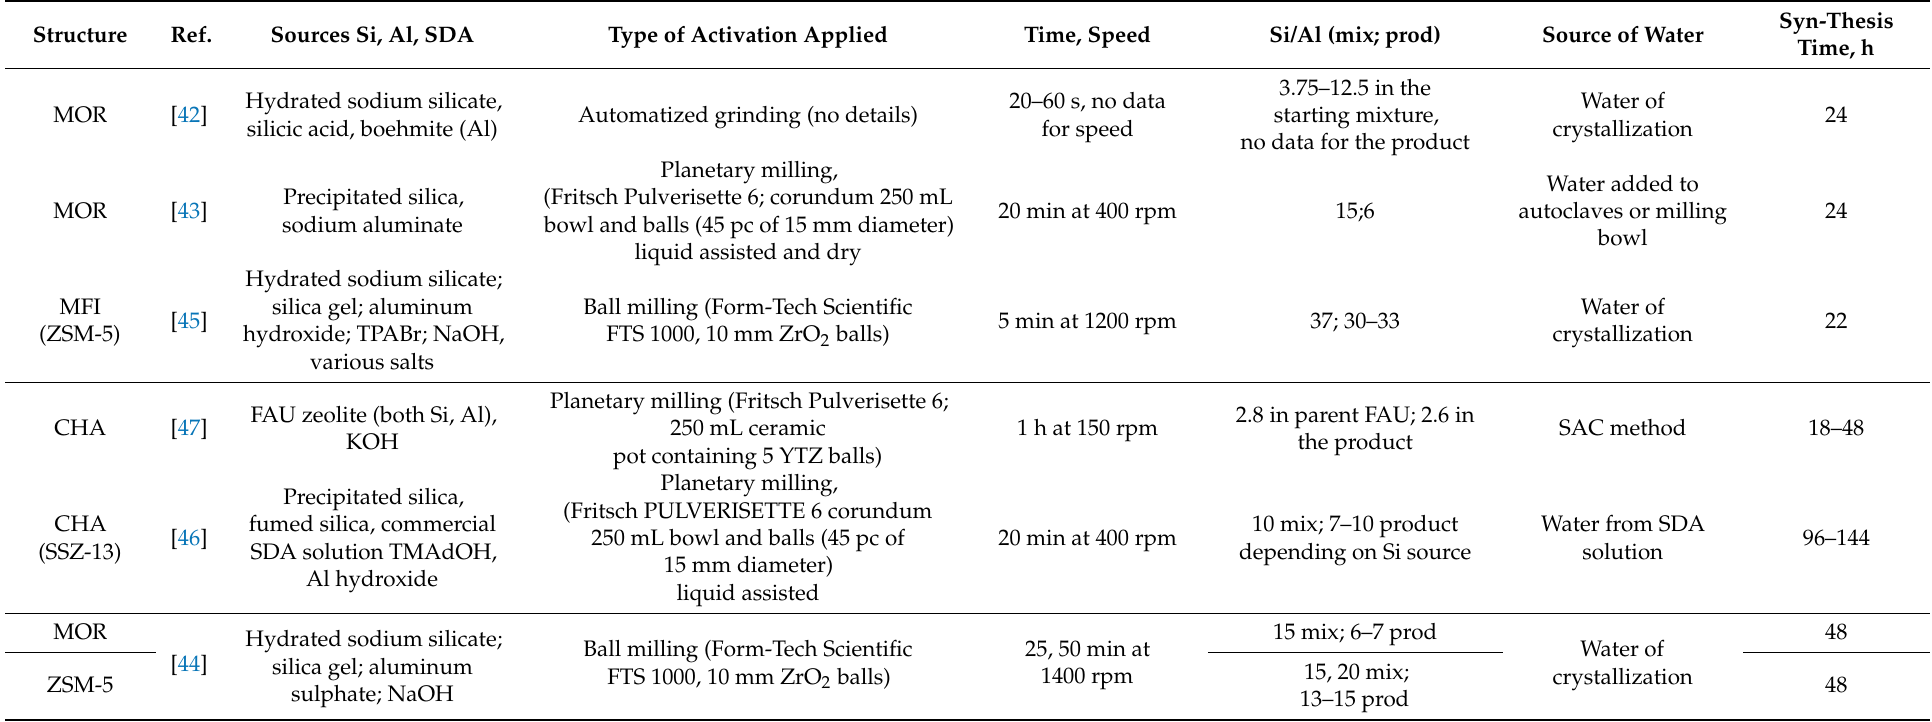
Table 1. Summary of reports on solvent-free syntheses of zeolites with automatized